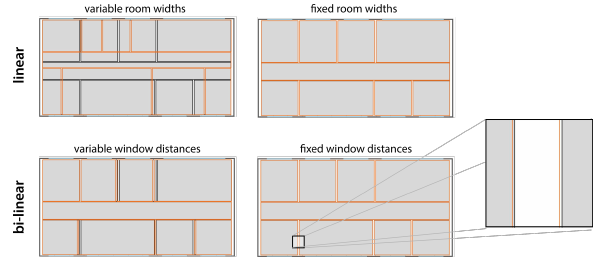
Figure 5: Floorplan estimation using a Gauss-Markov model. Model selection is performed based on linear (top) and bi-linear (bottom) constraints. Symmetries and repetitive patterns (fixed room widths, fixed window distances) are considered. The zoomed part on the right shows that the estimated (orange) and the ground truth model (black) are almost identical (Dehbi et al.,